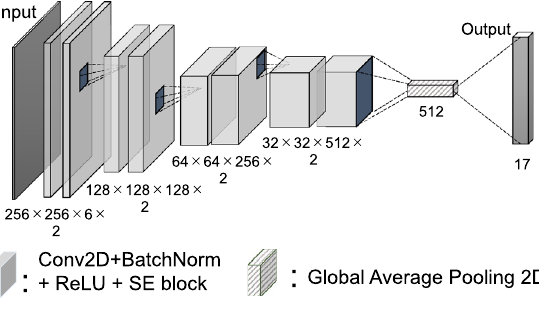
Figure 10. Original architecture for this study. The architecture consisted of total of eight layers of two dimensional convolution. The figures under each convolution layer indicate the size (height and width) and number of future maps and layers. “Conv2D” refers to 2-dimentional convolution. “BatchNorm” refers to batch normalization. “SE block” refers to Squeeze-and-Excitation block.